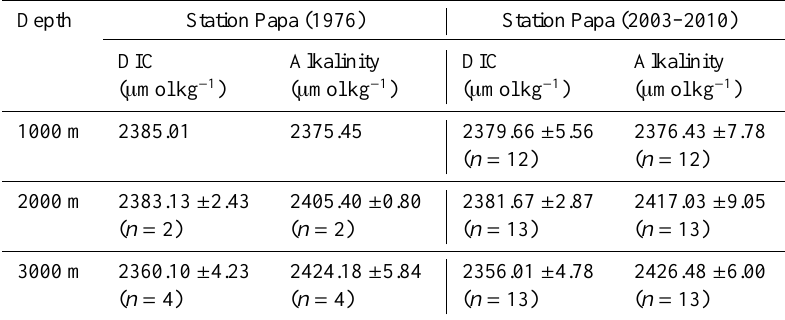
Table 3. Alkalinity and DIC measurements of deep-water samples collected at Station Papa in 1976 and between 2003 and 2010 and stored at